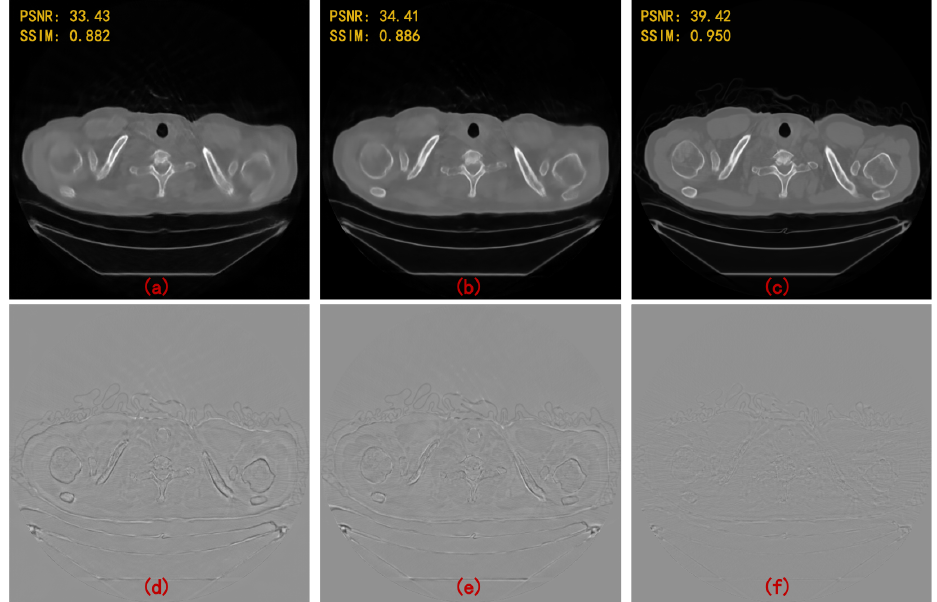
Figure 8. Reconstruction results and error maps of different hybrid domain methods at four angular intervals. ( a ) Dual-WCNN; ( b ) Dual-U-Net; ( c ) Dual-MWCNN; ( d ) error map of ( a ); ( e ) error map of ( b ); and ( f ) error map of ( c